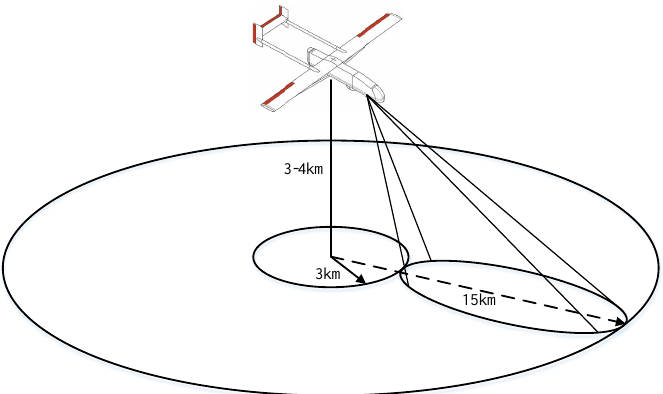
Figure 1. The unmanned aerial vehicle (UAV) Radar has a wide area of 360 deg Field of View (FOV), Radar antenna sweeps out an annular of 3–15 km. Doppler Radar is designed for the automatic detection and tracking of moving ground and marine vehicles as well as low-altitude (maximum altitude: 3–4 km) slow-flying aircraft such as general aviation aircrafts, and helicopters out to a range of 15